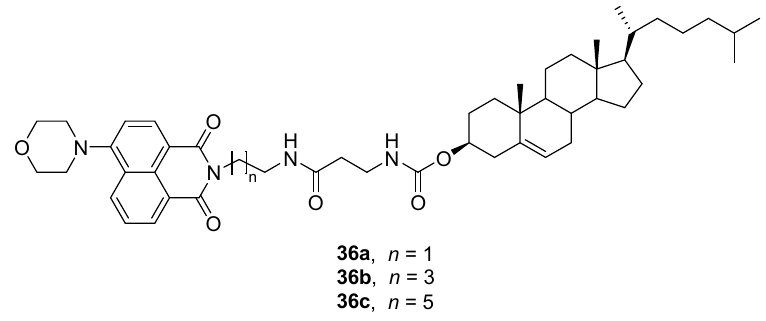
Figure 27. Chemical structure of cholesterol-based organogelators 36a–c .